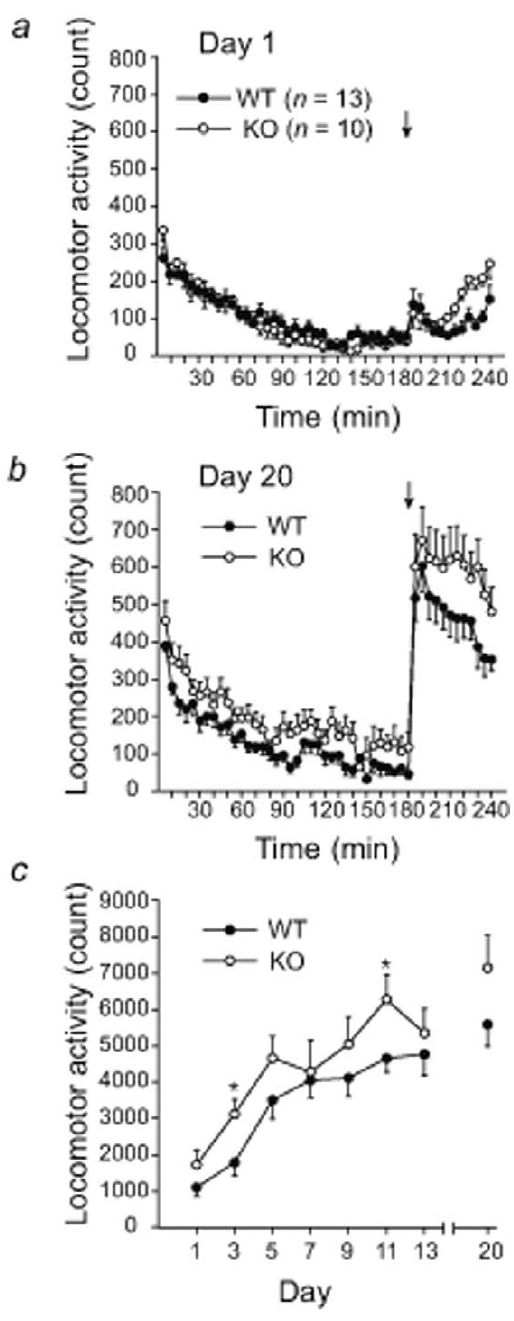
Figure 2. Spontaneous and METH-stimulated locomotor activ- ity in wildtype (WT) and ICER knockout (KO) mice. METH (1 mg/ kg) was administered once per day on Days 1, 3, 5, 7, 9, 13, and 20 in WT ( n =13) and ICER-KO ( n =13) mice. a . ime-course of spontaneous locomotor activity before and after METH administration on Day 1. The data are expressed as mean 6 SEM beam breaks in 5 min bins. The arrow indicates the start of a METH injection. b . Time-course of spontaneous locomotor activity before and after METH administration on Day 20. The data are expressed as mean 6 SEM beam breaks in 5 min bins. The arrow indicates the start of a METH injection. c . METH- induced locomotor sensitization. The data are expressed as mean 6 SEM beam breaks during the 60 min period after METH injection (1 mg/ kg). * p , 0.05, significant difference in locomotor activity scores between WT and KO